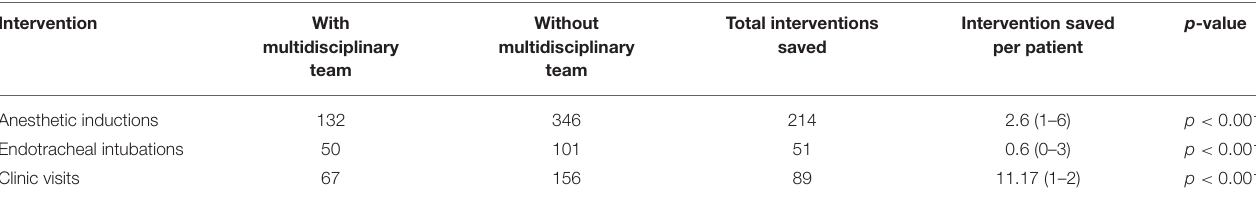
TABLE 3 | Comparison of the number of anesthetic inductions, clinic vistis, and endotracheal intubations perfomed per patient with and without a multidisciplinary approach. Intervention With